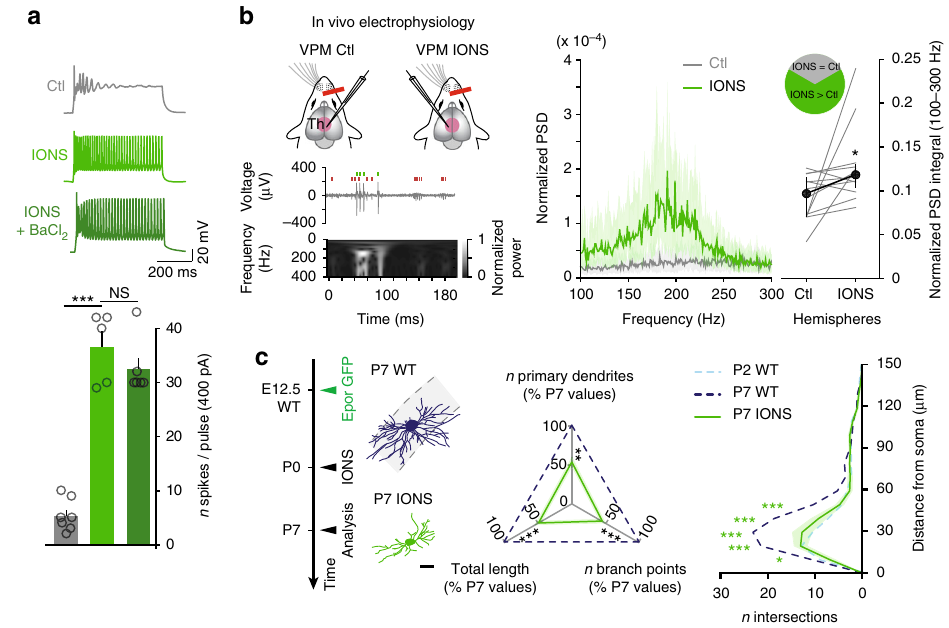
Fig. 4 VPM neurons are hyperexcitable following neonatal lesions of whisker input pathways. a At P15, IONS leads to increased excitability of VPM neurons, which occludes the effects of the K + channel blocker BaCl 2 . (Ctl n = 7, IONS n = 5, IONS + BaCl 2 n = 6). One-way ANOVA with Tukey's post-hoc test, *** P < 0.001, NS, not signi fi cant. b IONS causes increased burstiness of VPM neurons in vivo. Left, top: multiunit activity recorded in VPM IONS. Two putative single units can be identi fi ed (green and red tick marks). Left, bottom: increased power in the 100 – 300 Hz frequency band during bursting activity. Center: sample traces showing VPM neuron activity in vivo. Shaded areas represent the interquartile range of the power spectral density (PSD). Right: summary plot of the normalized PSD integral. Lines represent individual mice ( n = 12). Wilcoxon signed-rank test, * P < 0.05. c Dendritic complexity is strongly decreased following IONS (P7 IONS n = 10 from 2 mice). P7 WT and P2 WT data reported from Fig. 1b. One-way ANOVA with Tukey's post-hoc test for all statistical tests relating to dendritic complexity, except for Sholl analyses for which a two-way ANOVA with Tukey's post-hoc test was used. * P < 0.05, ** P < 0.01, *** P < 0.001. Scale bar: 20 μ